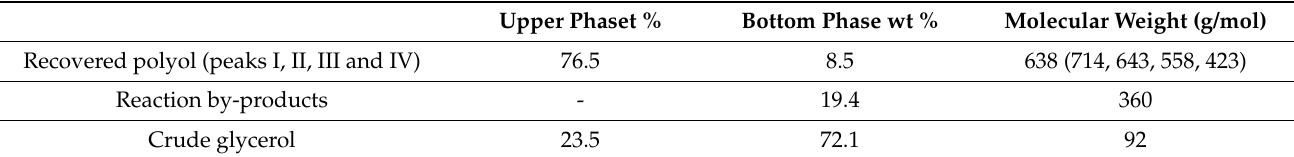
Table 2. Concentration in wt % of the different compounds in the UP and BP at the end time of the reaction. Upper Phaset % Bottom Phase wt % Molecular Weight (g/mol) Recovered polyol (peaks I, II, III and IV) 76.5 Reaction by-products -